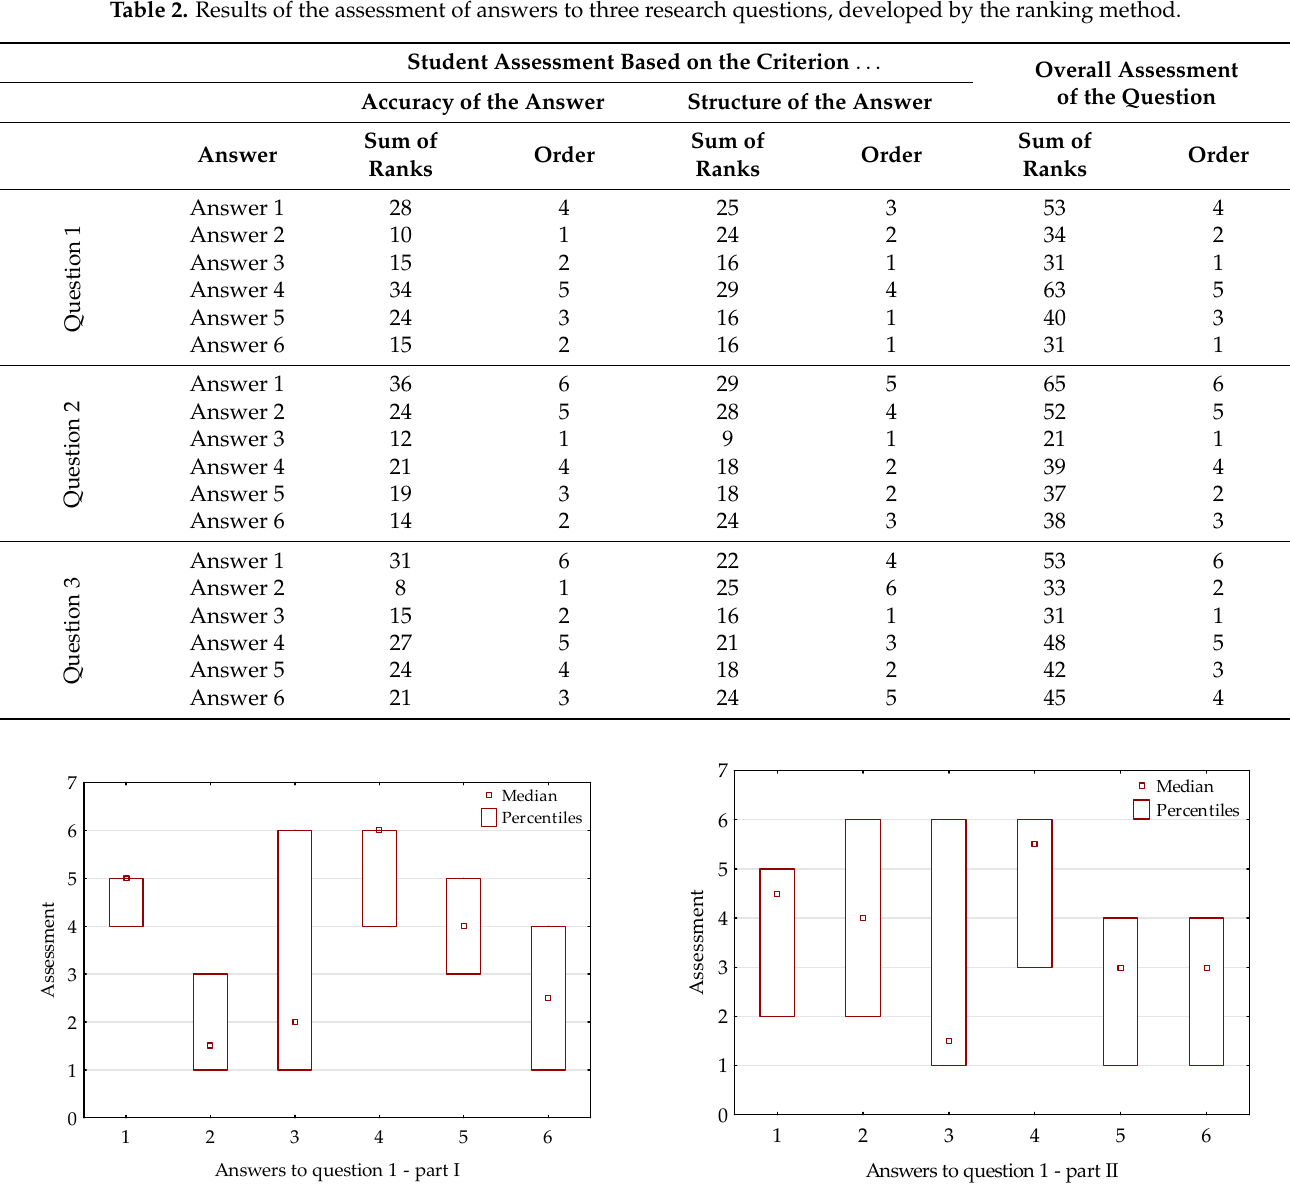
Figure 1. Box-whisker charts for the mean ranks of the assessed answers in question 1 for the accuracy of answers criterion ( part I ) and the criterion of the answer structure ( part II ).